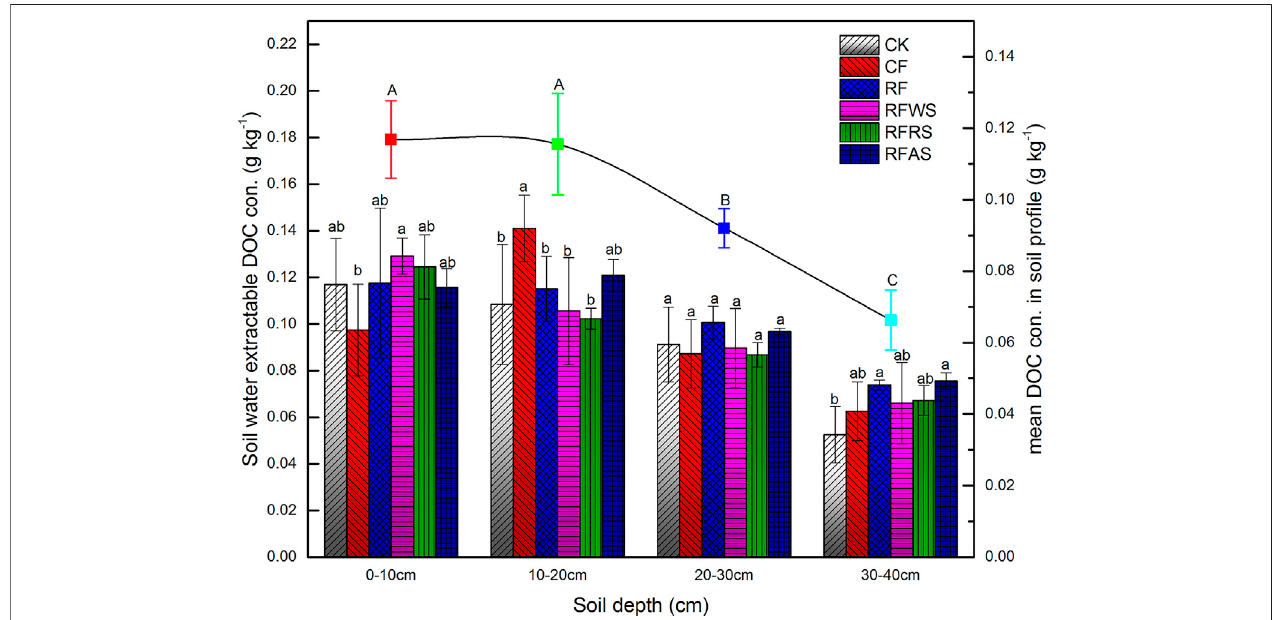
FIGURE2| ContentofDOM (representedbyDOCconcentration)fromsoilssampledafterleachingtest. Differentcolorbarsrepresent differenttreatments (treated in 0 – 10 cm) (CK: control treatment without organic material and fertilizer; CF: conventional fertilizer applied; RF: reduced 20%fertilizer compared withCF; RFWS: wheat straw combined with RF; RFRS: rapeseed shell combined with RF; RFAS: astragalus smicus combined with RF).